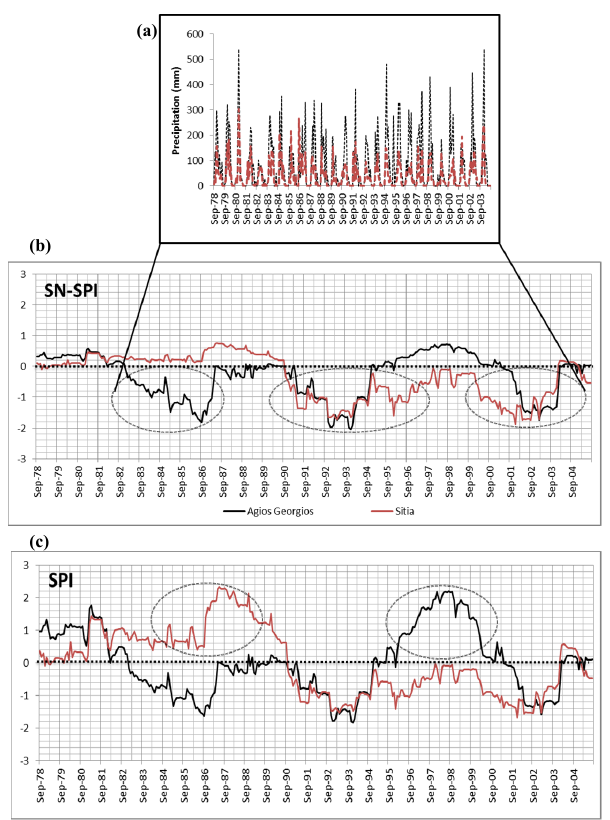
Fig. 7. Spatial separation of 55 stations using cluster analysis. (a) Stations plot illustrating drought months as the dependent vari- able and (b) silhouette plot of the